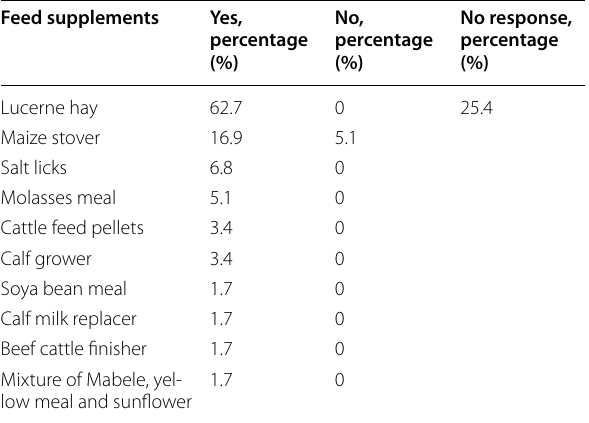
Table 4 Farmers’ perception of acceptable feed supplements for cattle in the dry season